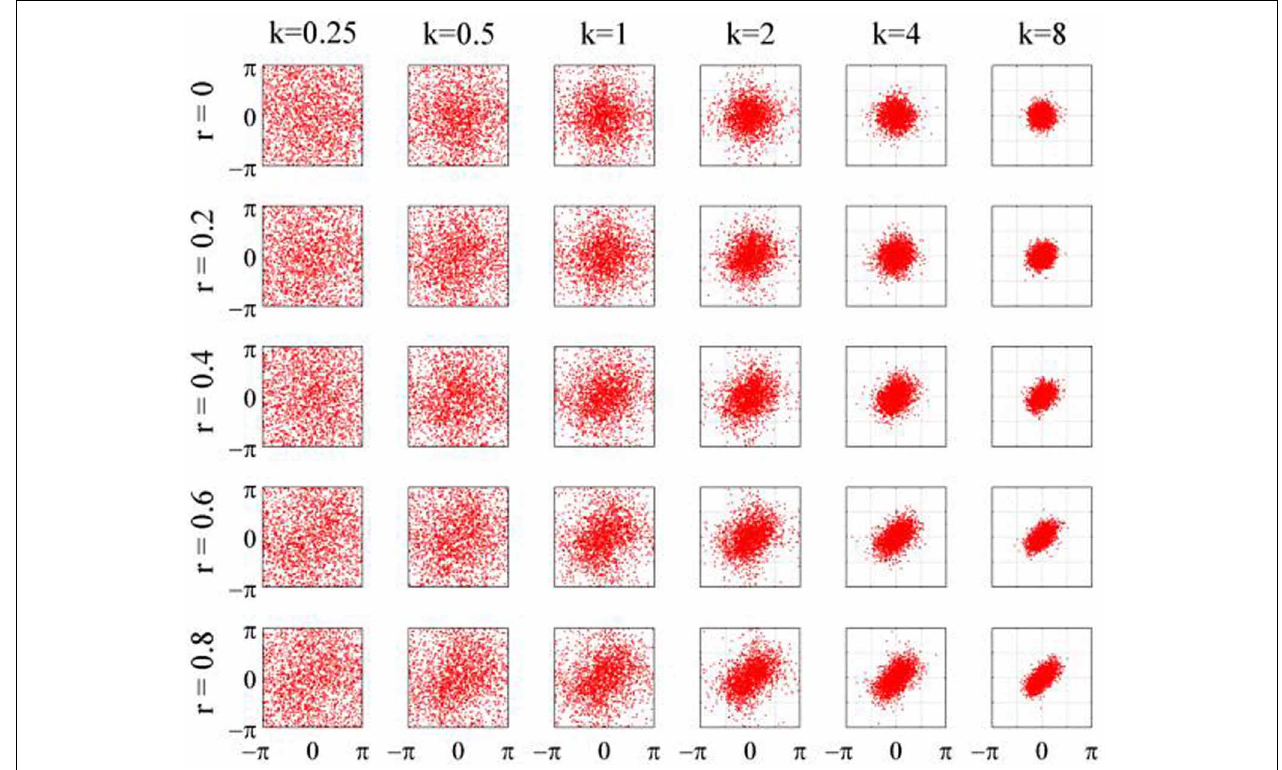
FIGURE 3 | Scatterplots of the 2D-von Mises distribution for different values of concentration, κ , and correlation, r .